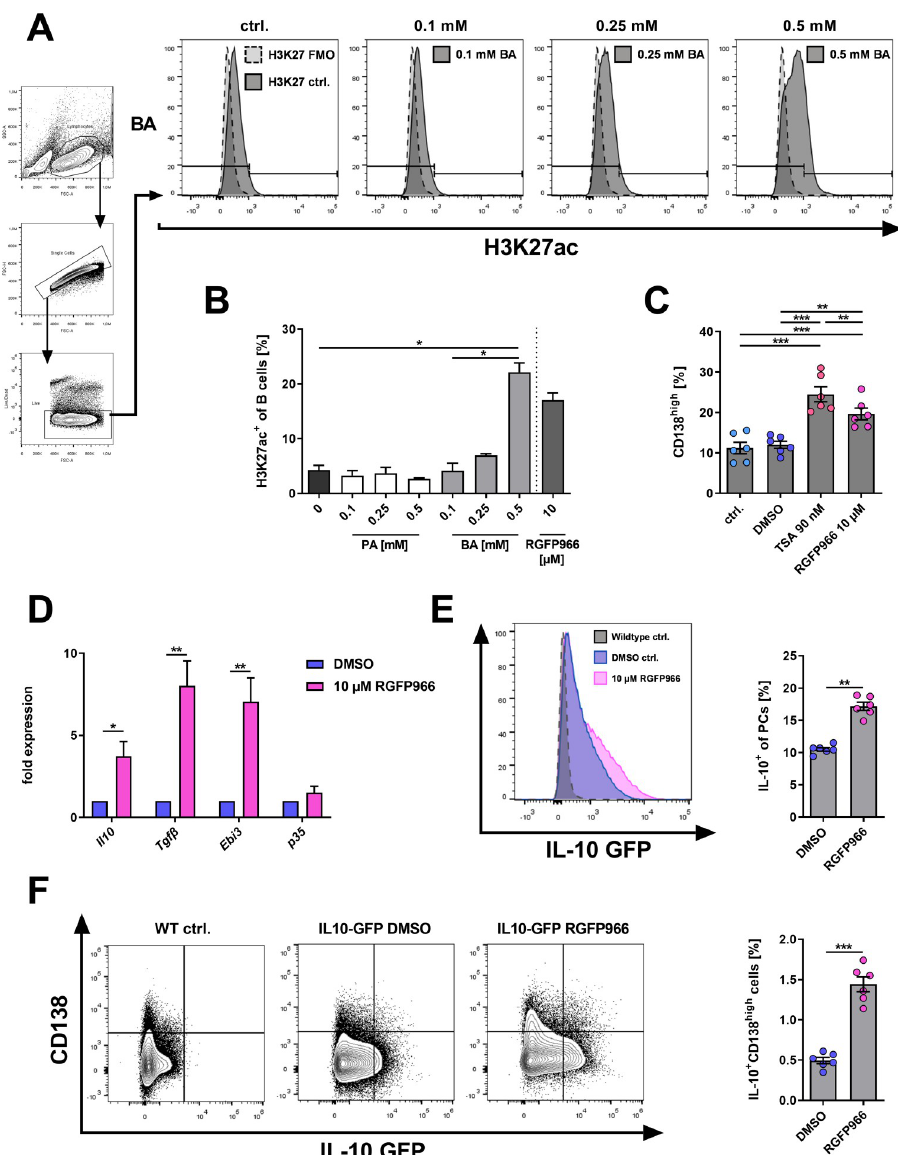
Fig 6. Specific HDAC3 inhibition by RGFP966 promotes the differentiation of CD138 high PCs, IL-10 + B cells, and IL-10 + CD138 high PCs in isolated murine B cells. (A) Flow cytometric gating strategy and representative histogram plots of H3K27 acetylation in isolated murine B cells after 3 days of cell culture. (B) Frequencies of H3K27ac + cells in isolated murine B cells after 3 days of incubation with increasing concentrations of PA and BA (n = 3). Treatment with RGFP966 (10 μ M) as a positive control. (C) Frequencies of CD138 high PCs after 4 days of incubation of isolated murine B cells with HDAC inhibitor TSA or HDAC3-specific inhibitor RGFP966. (D) Gene expression of anti-inflammatory cytokines after 4 days of cell culture with 10 μ M RGFP966 (n = 6). (E) Representative overlay histogram plot and IL-10 GFP protein expression among all CD138 high PCs after 4 days of B cell culture with 10 μ M RGFP966 (n = 6). (F) Representative contour plots and frequencies of IL-10 + CD138 high PCs among all B cells after 4 days of B cell culture with 10 μ M RGFP966. TSA = Trichostatin A. � p < 0.050, �� p < 0.010, ��� p < 0.001. levels after treatment of B cells with RGFP966 for four days were determined by qPCR. Indeed, while p35 expression was not changed significantly, the expression levels of Il10 (p = 0.0284), Tgfb1 (p = 0.0055), and Ebi3 (p = 0.0087) were increased significantly ( Fig 6D ). Moreover,